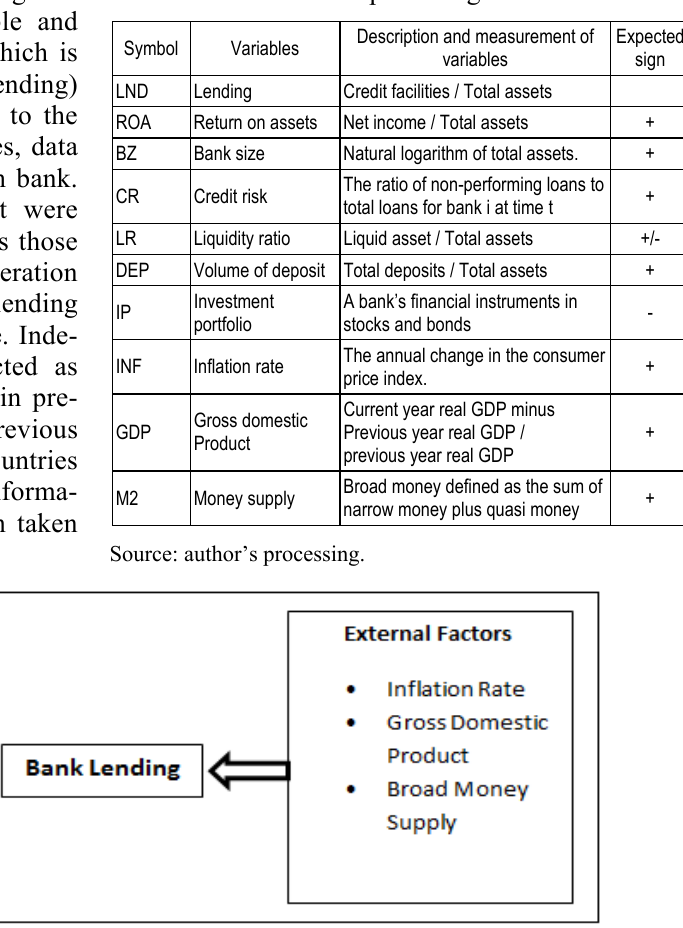
Table 3. Definition of variables (proxies), symbols